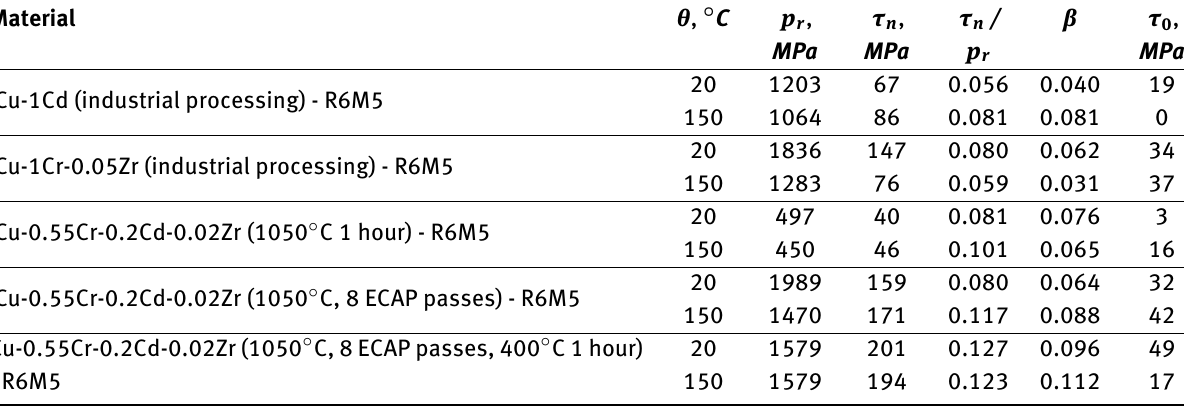
Table 5: Assessment of tribological parameters of the contact on bronze after different treatment